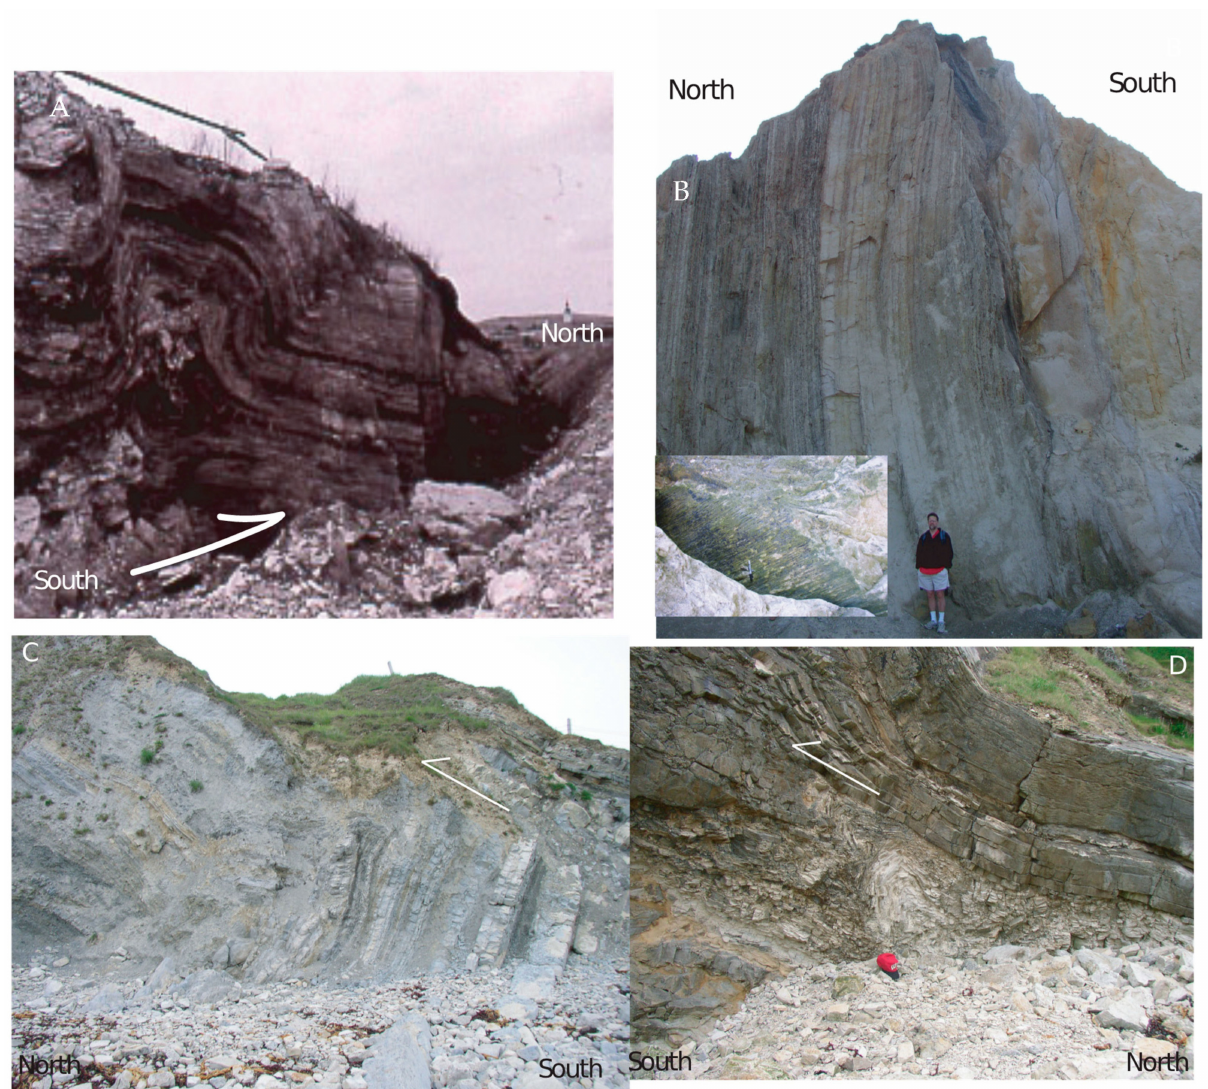
Figure 5. Field photos from the distal Alpine foreland. ( A ) Ramp anticline in Jurassic limestones and evaporites with a south-dipping thrust, Markt Nordheim, Germany. ( B ) Vertical Cretaceous limestones, Isle of Wight, UK, with inset of oblique-slip striations. ( C , D ) Thrust contraction structures in Jurassic limestones, Lulworth Cove,